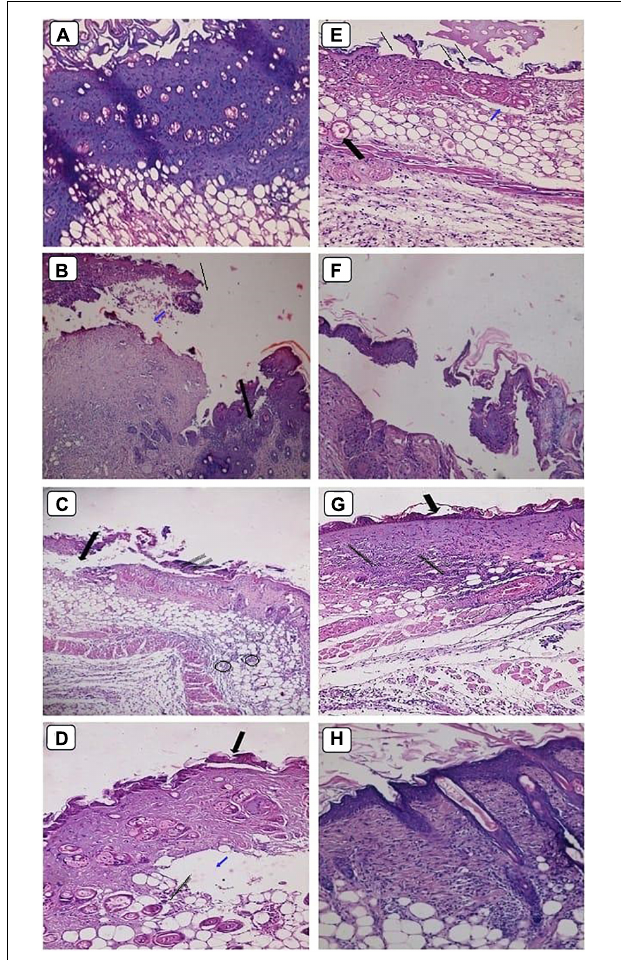
FIGURE 9 | Histopathological examination of skin mice groups burned, infected and received different treatment during 1st stage (A–D) , and 2nd stage of treatment (E–H) . G4 skin treated with Ag-NPs gel (A,E) . G5 skin treated with neomycin gel (B,F) . G6 skin treated with neomycin-Ag-NPs gel (C,G) . G7 skin treated with neomycin-Ag-NPs spray (D,H) . Magnification power (200 × ). (A) Discontinuity of epithelial cells with vacuolation in the underlying epidermis. (B) Loss of epidermis (thin arrow), edema space with large lytic area (blue arrow), and massive infiltration with inflammatory cells (thick arrow). (C) Loss of epidermis layer underlying a massive infiltration with inflammatory cells (thin arrow), separation between dermis, and epidermis layers (thick arrow), and infiltration with inflammatory cells between the fat cells (circles). (D) Migrating epithelium cells (thick arrow) with the appearance of edema space (blue arrow) in the dermis layer embedded with mild infiltration (thin arrow). (E) Discontinuity of epidermis (thin arrow), edema space in the dermis layer (blue arrow), and congested blood capillary (thick arrow). (F) Separation between skin layers with edema space underlying the epithelium cells with massive infiltration. (G) Distortion of epidermis layer in few areas (thick arrow), and massive infiltration in the dermis layer (thin arrow). (H) Normal-looking skin with regular collagen distribution, normal-looking hair